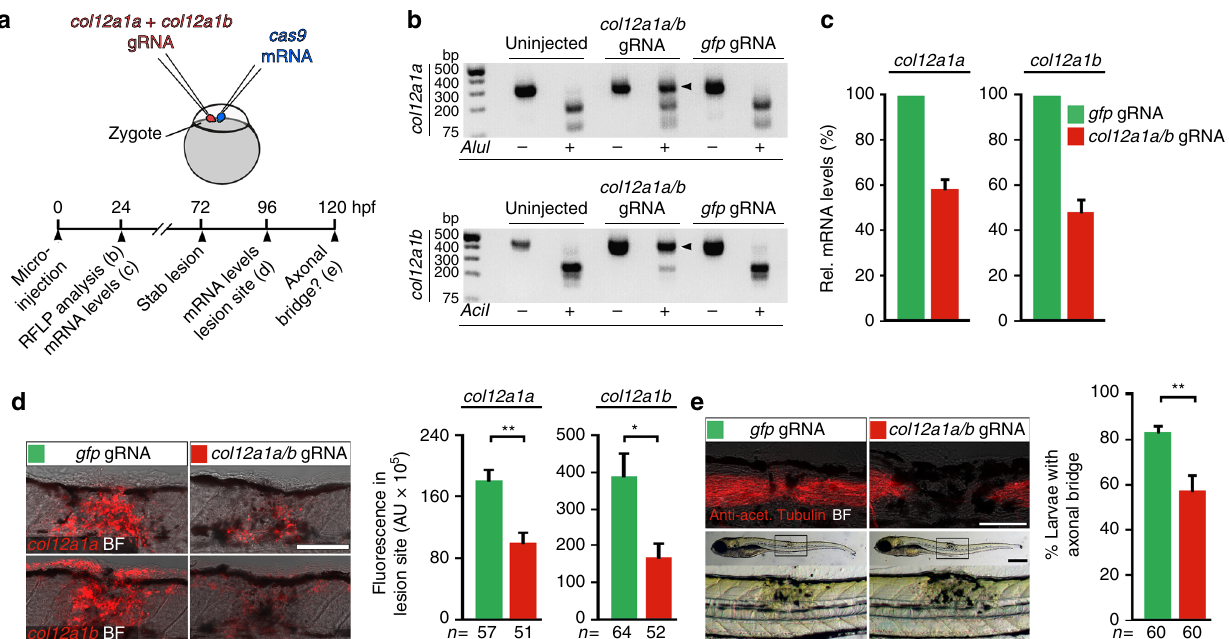
Fig. 6 CRISPR/Cas9-mediated disruption of col12a1a/b leads to depletion of mRNA and impaired axonal regeneration. a Cartoon showing strategy used for CRISPR/Cas9-mediated col12a1a/b gene disruption. cas9 mRNA and small guide-RNA (gRNA) targeting col12a1a and col12a1b were co-injected into the zygote. Crispants were analysed for col12a1a/b mRNA levels and axonal regeneration as indicated in the timeline. b Restriction fragment length polymorphisms (RFLP) analysis reveals ef fi cient somatic mutation in the gRNA target site (indicated by resistance to restriction endonuclease digest; arrowheads) in both col12a1 paralogs after microinjection. c col12a1a/b Crispants exhibit reduced developmental col12a1a and col12a1b mRNA expression, determined by quantitative RT-PCR. Representative plot from three independent experiments for each mRNA are shown. mRNA levels in gfp gRNA-injected control animals were set to 100%. d col12a1a/b Crispants exhibit reduced col12a1a and col12a1b mRNA levels after lesion, determined by quanti fi cation of fl uorescent in situ hybridization signal in the lesion site ( t -test: ** P < 0.01, * P < 0.05). e col12a1a/b Crispants show reduced axonal bridging events after lesion ( t -test: ** P < 0.01). a – e Views are lateral (dorsal is up , rostral is left ). BF: bright fi eld. Scale bars : 200 µ m e and 100 µ m d , e . Error bars indicate